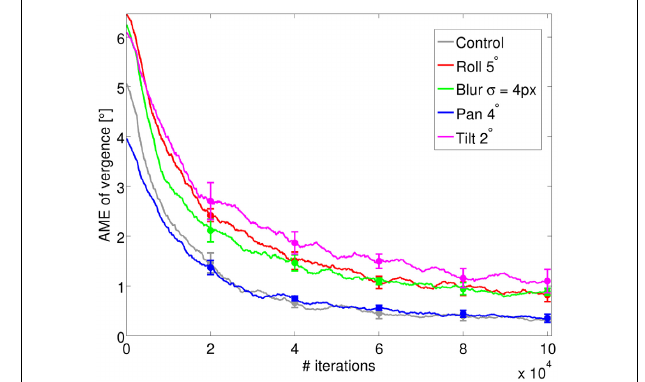
FIGURE 3 | The AME of vergence during training for the four types of perturbations introduced (blur, roll, pan, and tilt), averaged over 5 simulations. The control represents the case where no perturbation is applied (gray line). The AME for a random policy is ∼ 7.5 ◦ (not shown). Error bars represent one standard